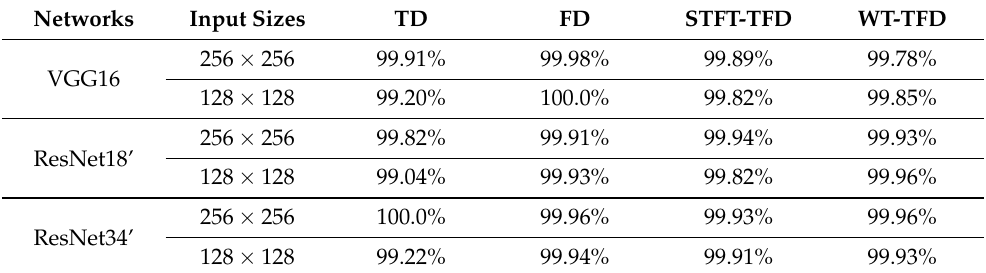
Table 8. Test accuracies of